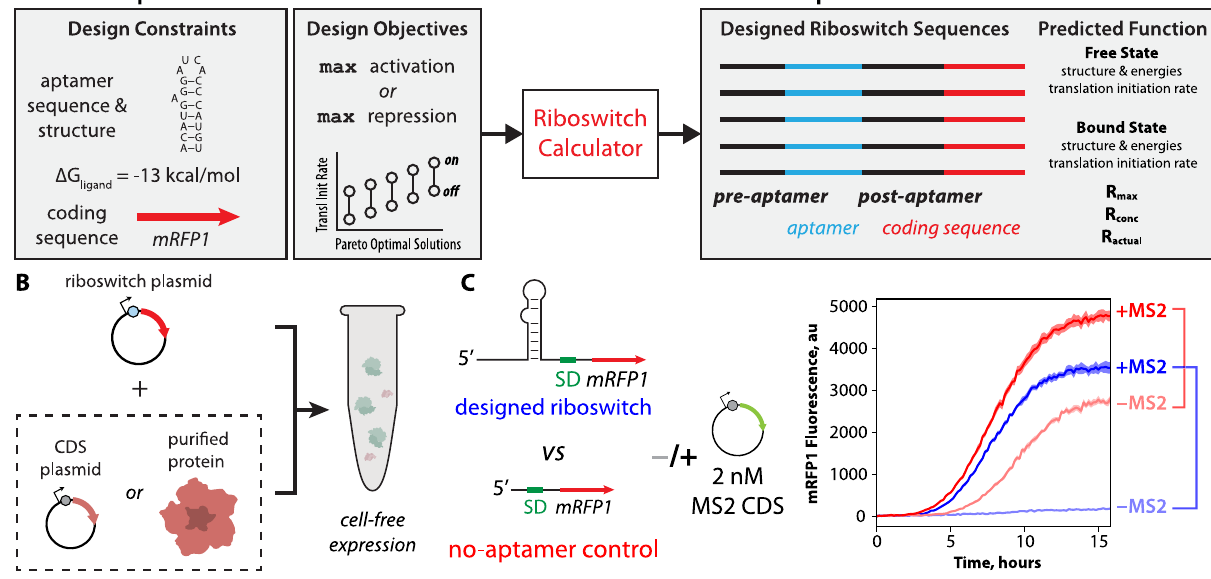
Fig. 1 | Design of protein-sensing riboswitches and cell-free riboswitch char- acterization. A A model of translation-regulating riboswitches takes as inputs the sequence, structure, and binding free energy of a protein-binding RNA aptamer. The model designs candidate riboswitch sequences that maximize activation or repressionoftranslationinitiationinresponsetochangingproteinconcentrations. B The riboswitch sensor is tested in a cell-free expression system (TX-TL), adding eitherproteinexpressionplasmidorpuri fi edprotein. C